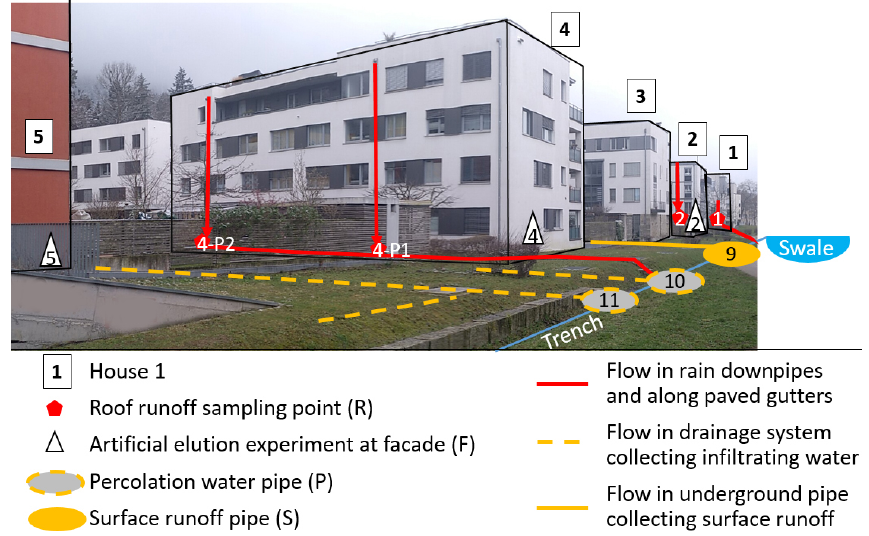
Figure 3. Side view of storm water management infrastructure and sampling